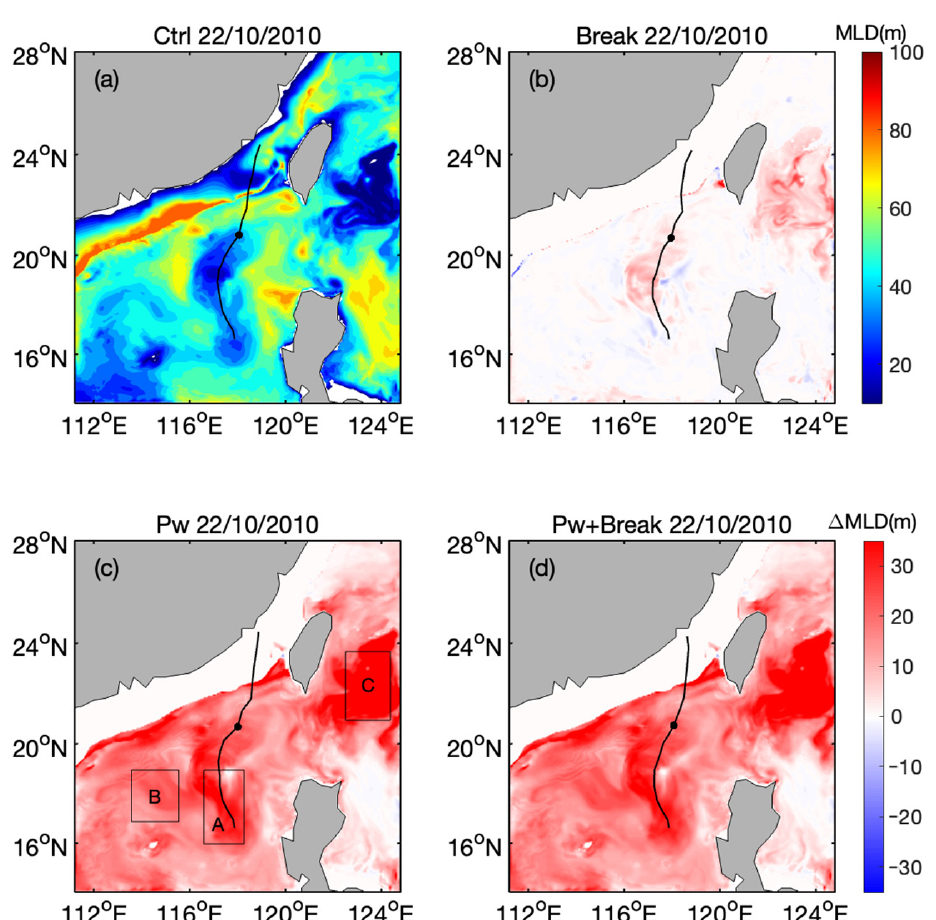
Figure 4. Same as Figure 3, but for MLD. ( a ) MLD in the control experiment excluding wave-induced mixing. ( b – d ) Deviations of MLD compared with the control experiment for each of the three experiments including mixing owing to surface waves.